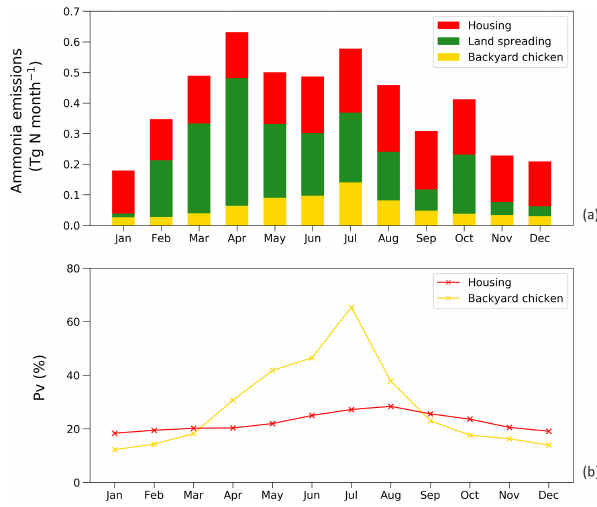
Figure 14. (a) Monthly NH 3 emissions (TgNyr − 1 ) from chicken housing, manure applications to crops and land spreading of back- yard chicken manure in 2010. (b) Percentage of excreted nitrogen that volatilizes ( P V ) as NH 3 monthly for chicken housing and land spreading of backyard chicken